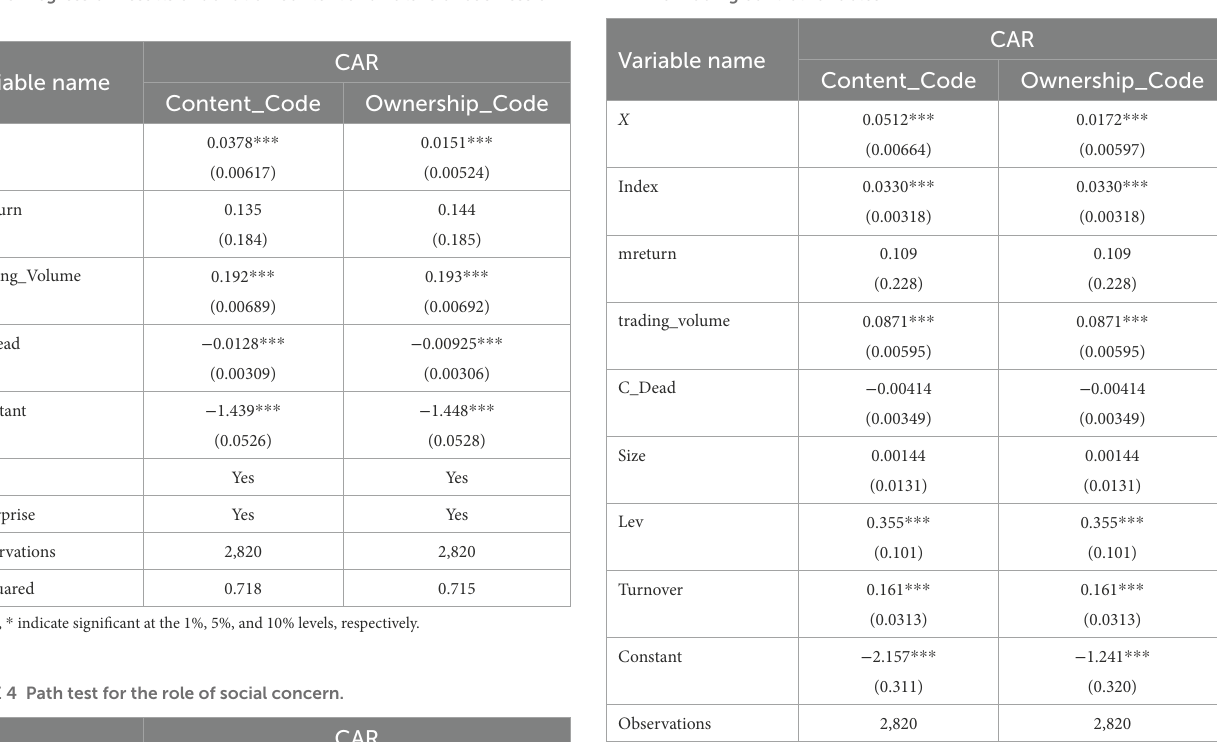
TABLE 5 Adding control